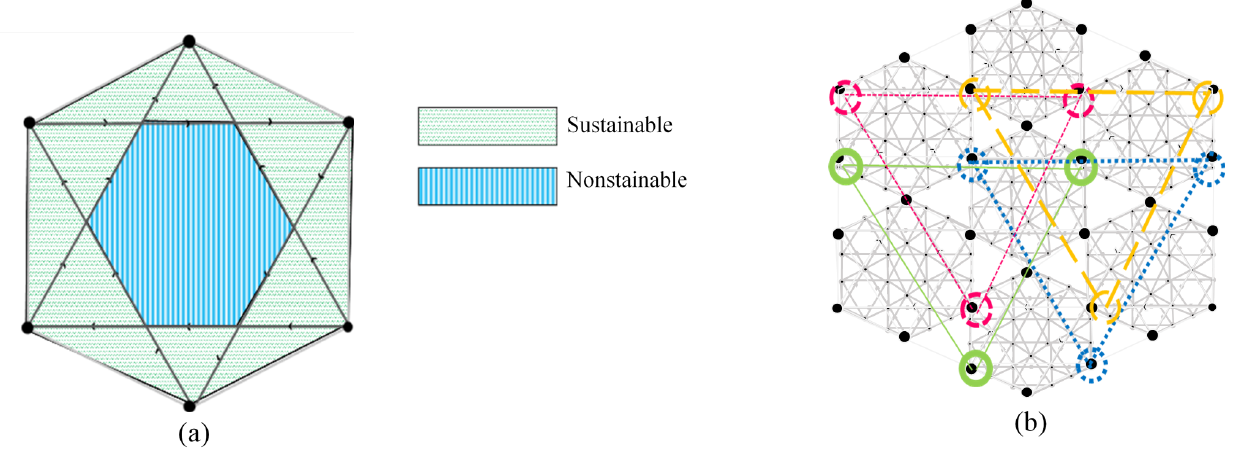
Figure 9. Fractalization ( a ) and interrelationships ( b ) in the model, as a result of the transposal of the hypercube, authors source.